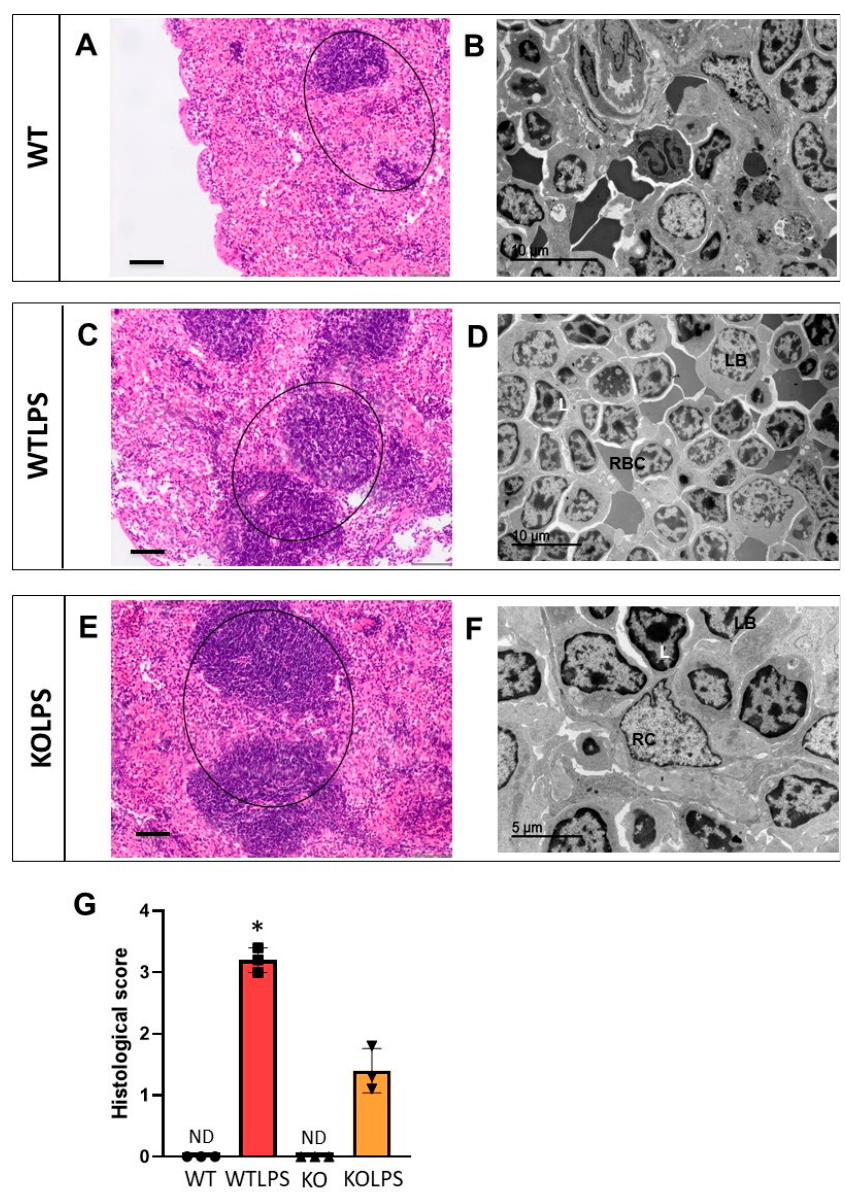
with LPS; KO, Gal3 knockout mice; KOLPS, Gal3 knockout mice treated with LPS; ND, not dam- aged. ( A , C , E ), optical microscopy. Scale bars: 100 μ m. ( B , D , F ), ultrastructural observations. Scale bars: ( B ), 10 μ m; ( D , F ), 5 μ m.